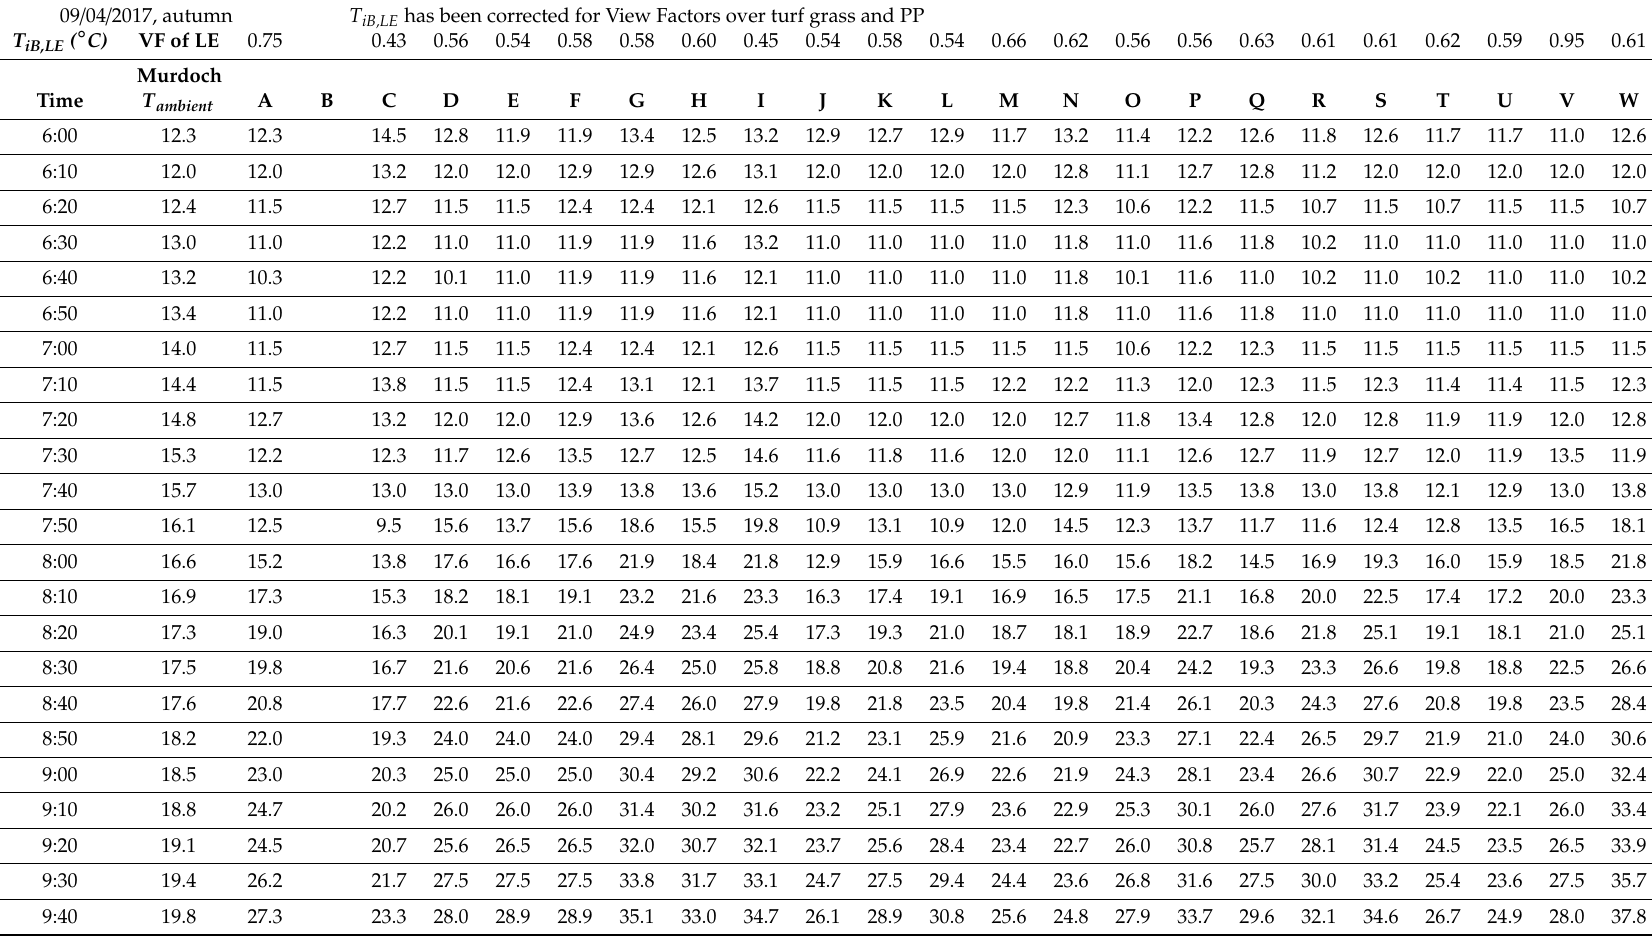
Table A1. iButton temperatures due to the landscape element (LE) only (after correction for VFs of surroundings). 09 / 04 / 2017, autumn T iB,LE has been corrected for View Factors over turf grass and PP